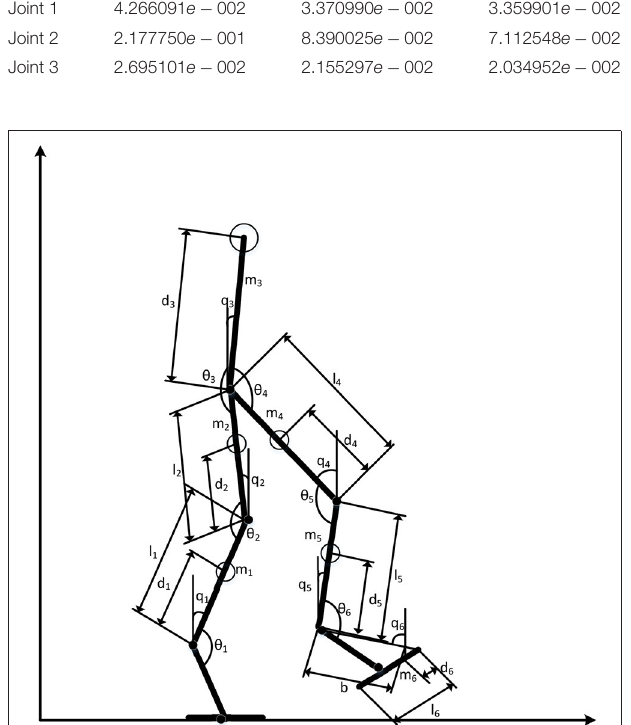
FIGURE 8 | The six-links biped robot used in the experiment.